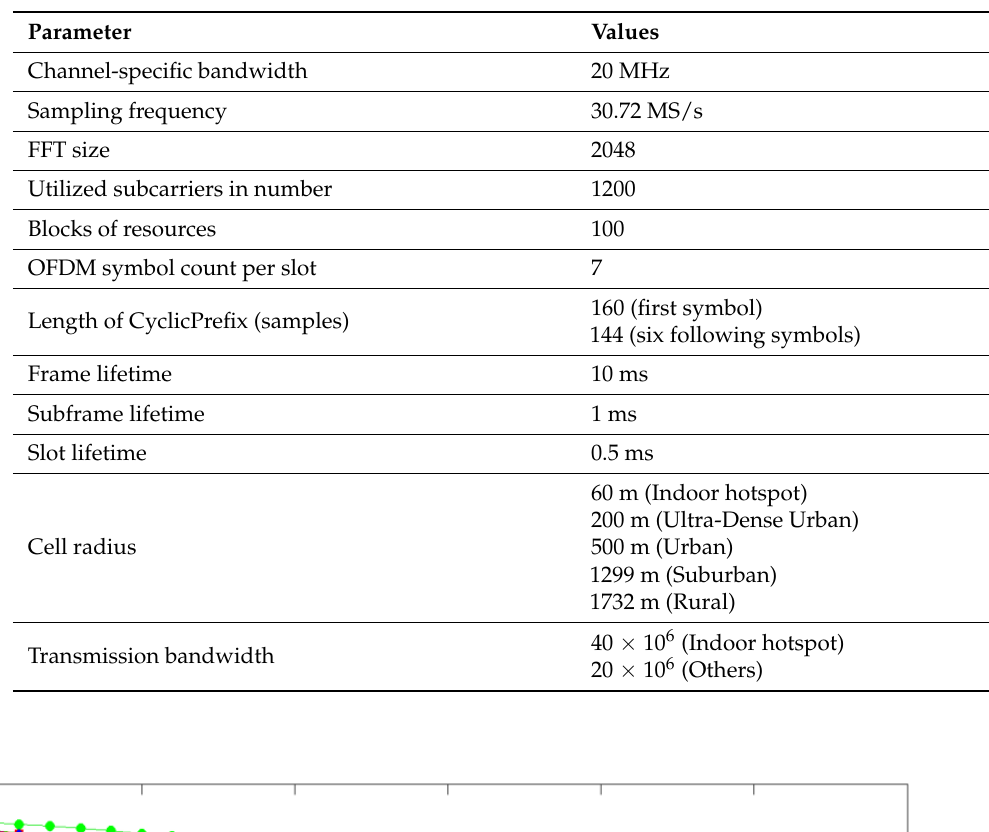
Table 3. System Parameters for MIMO Application Context.